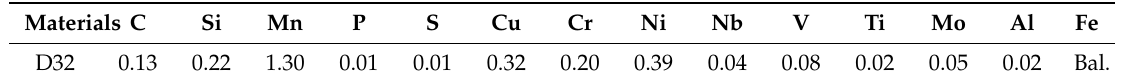
Table 1. Chemical composition of D32 wt %.